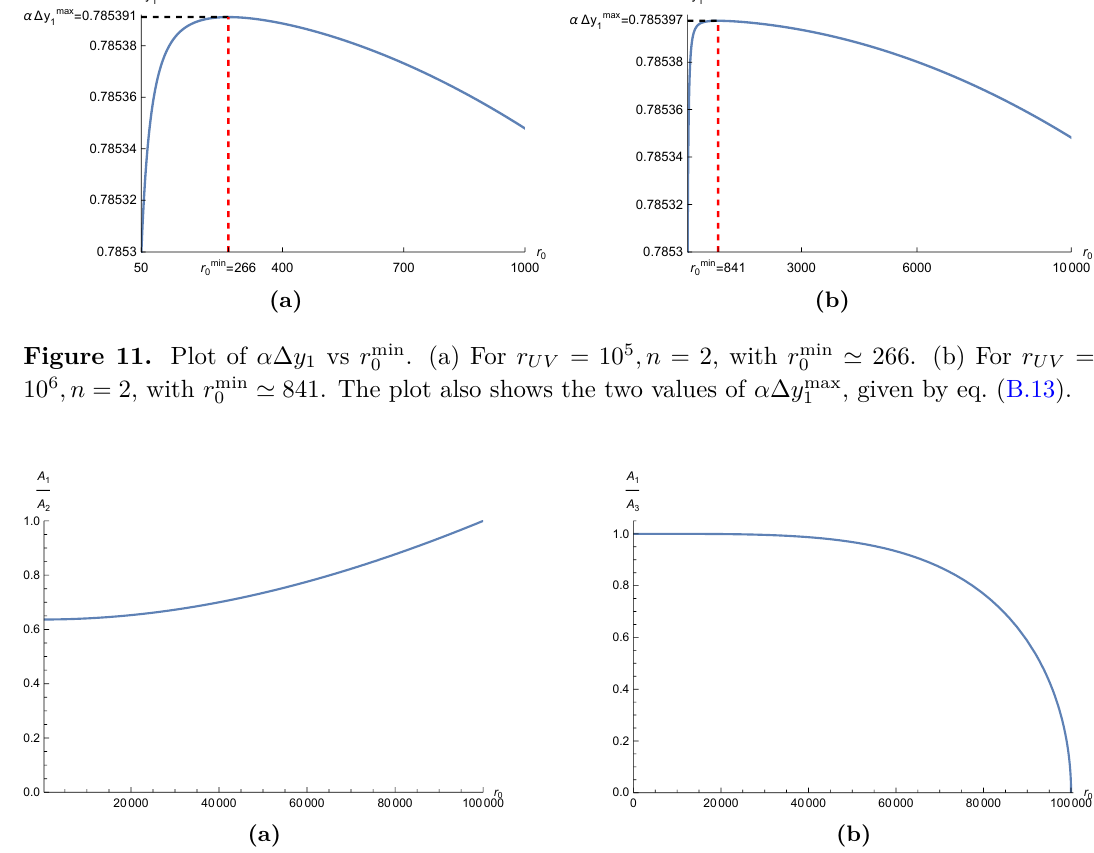
and A 1 for r UV = 10 5 , n = 2 . In both plots r min A 2 A 3